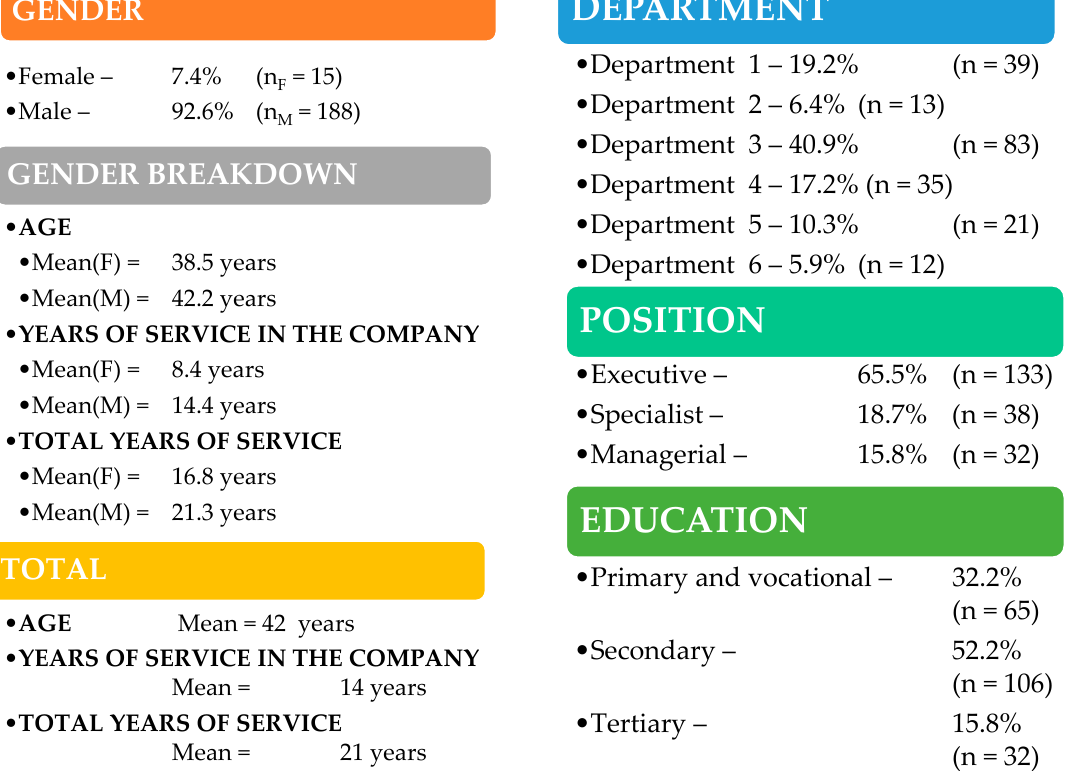
Figure 1. Selected measures of descriptive statistics for the surveyed population. Source: own elab- oration based on the results of empirical research carried out in the analysed international manu- facturing company, n = 203.